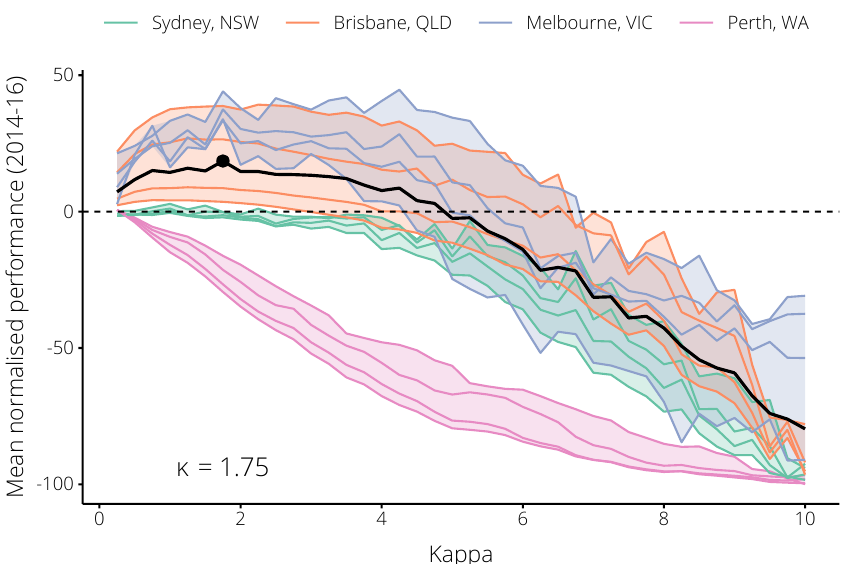
Figure 5. The trends in mean annually-normalised performance (cid:98) b k for each city over the 2014–2016 influenza seasons, relative to the non-calibrated forecasts (the horizontal dashed line). Each set of coloured lines depicts the performance (cid:98) b k for a city against the four chosen forecasting targets (see text for details). The solid black line is the overall trend for all cities except Perth; the optimal value of κ according to this trend is indicated by the black circle on this line ( κ =